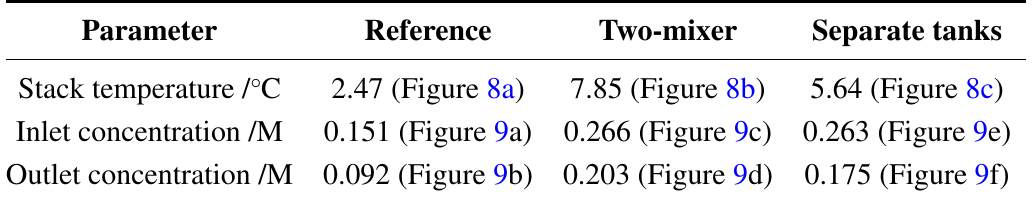
Figure 7. ( a ) The input current profile and ( b ) the resulting output voltage in simulations and experiments for all systems. Table 3. Root mean squared absolute error between simulations and experiments of each system for stack temperature, inlet and outlet